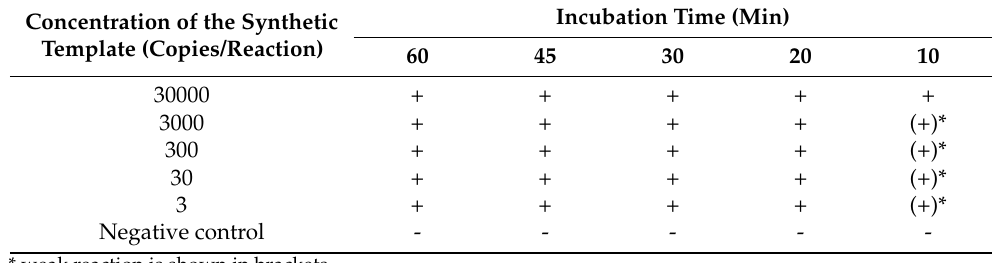
* weak reaction is shown in brackets.